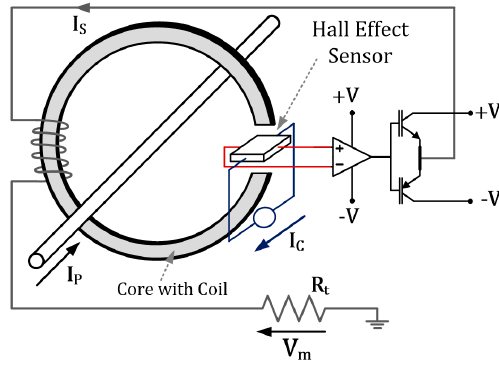
Figure 2. Current sensor scheme based on the Hall effect.